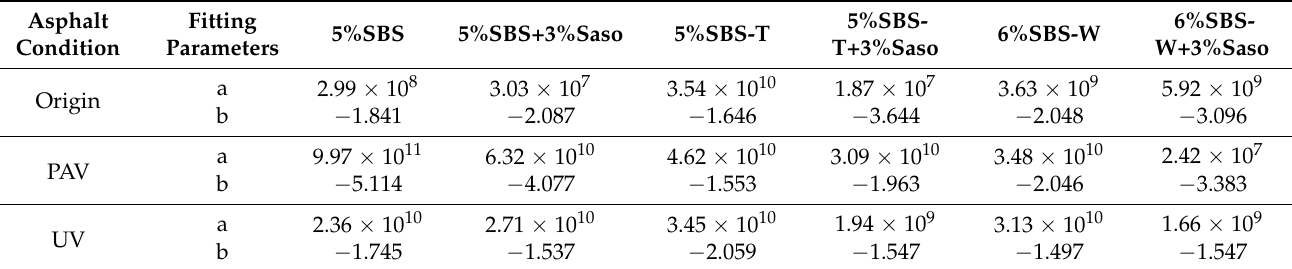
Table 9. Fatigue equation parameters of the